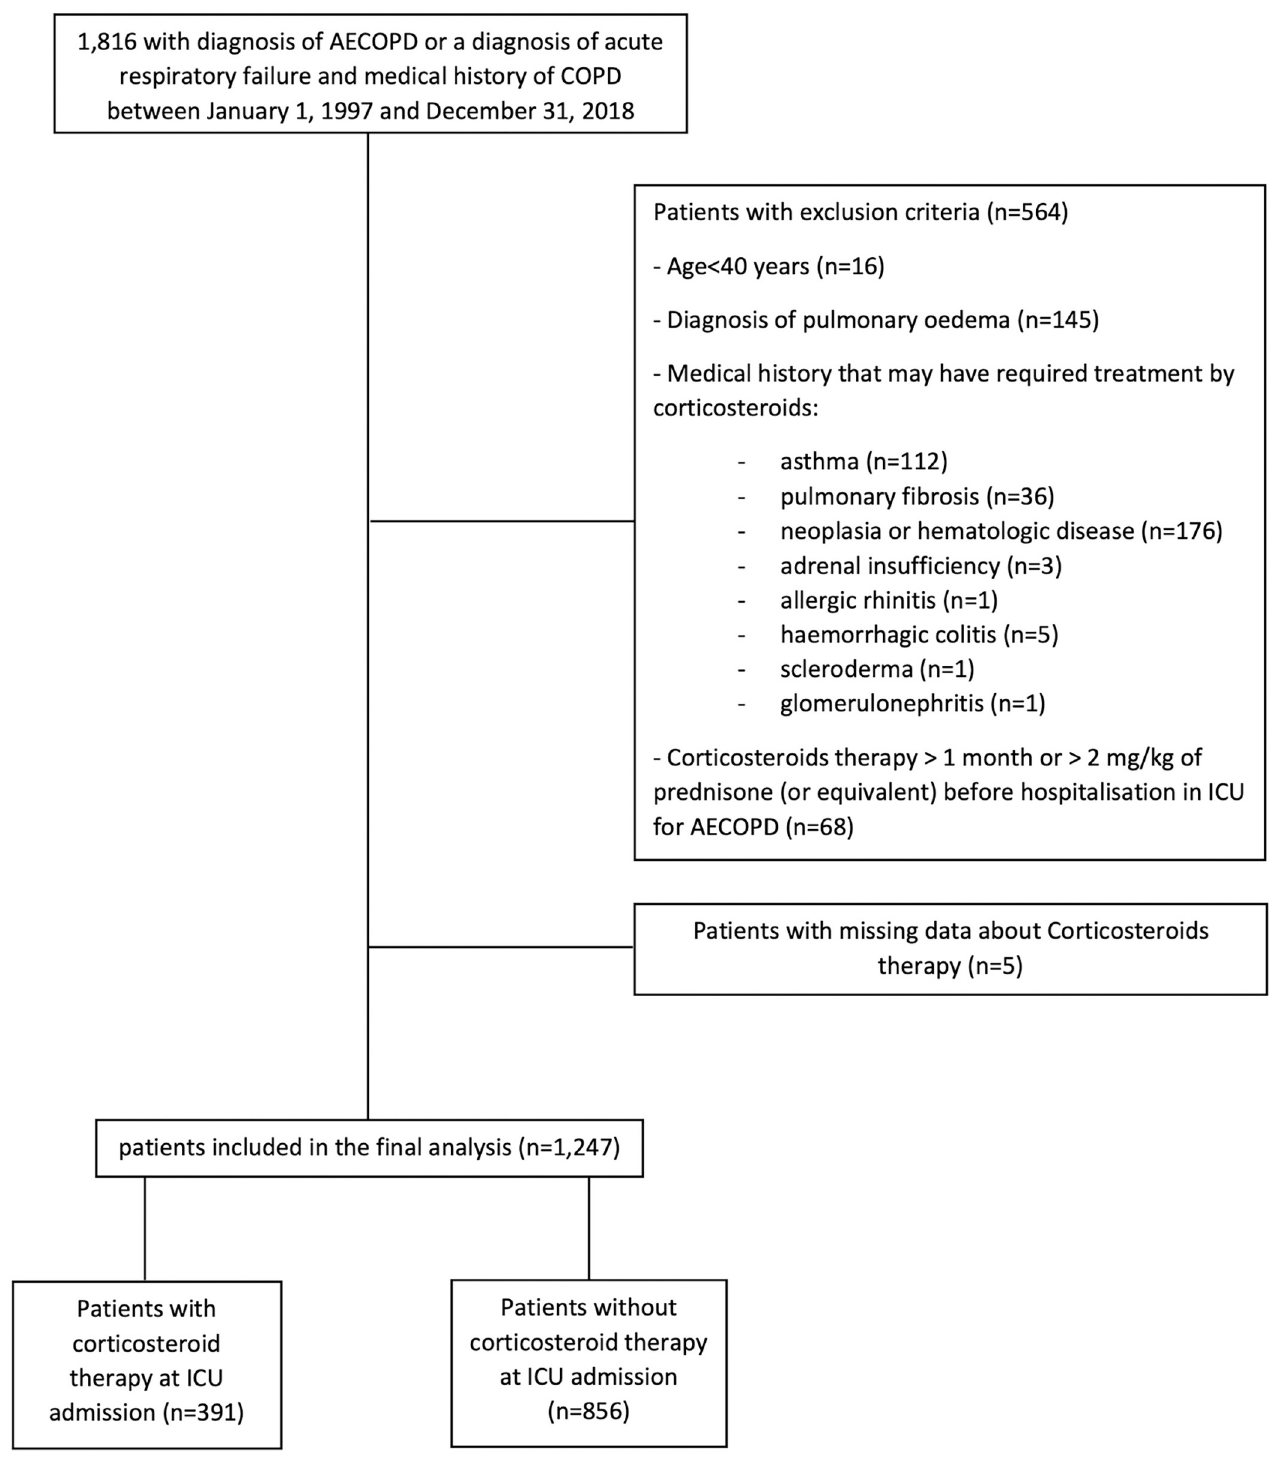
Fig 1. Study flow chart. AECOPD: Acute exacerbation of chronic obstructive pulmonary disease. COPD: Chronic obstructive pulmonary disease.